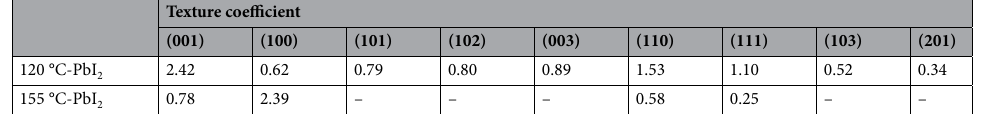
Table 1. The texture coefficients in for the crystal planes of PbI 2 chemically bath deposited at different temperatures.